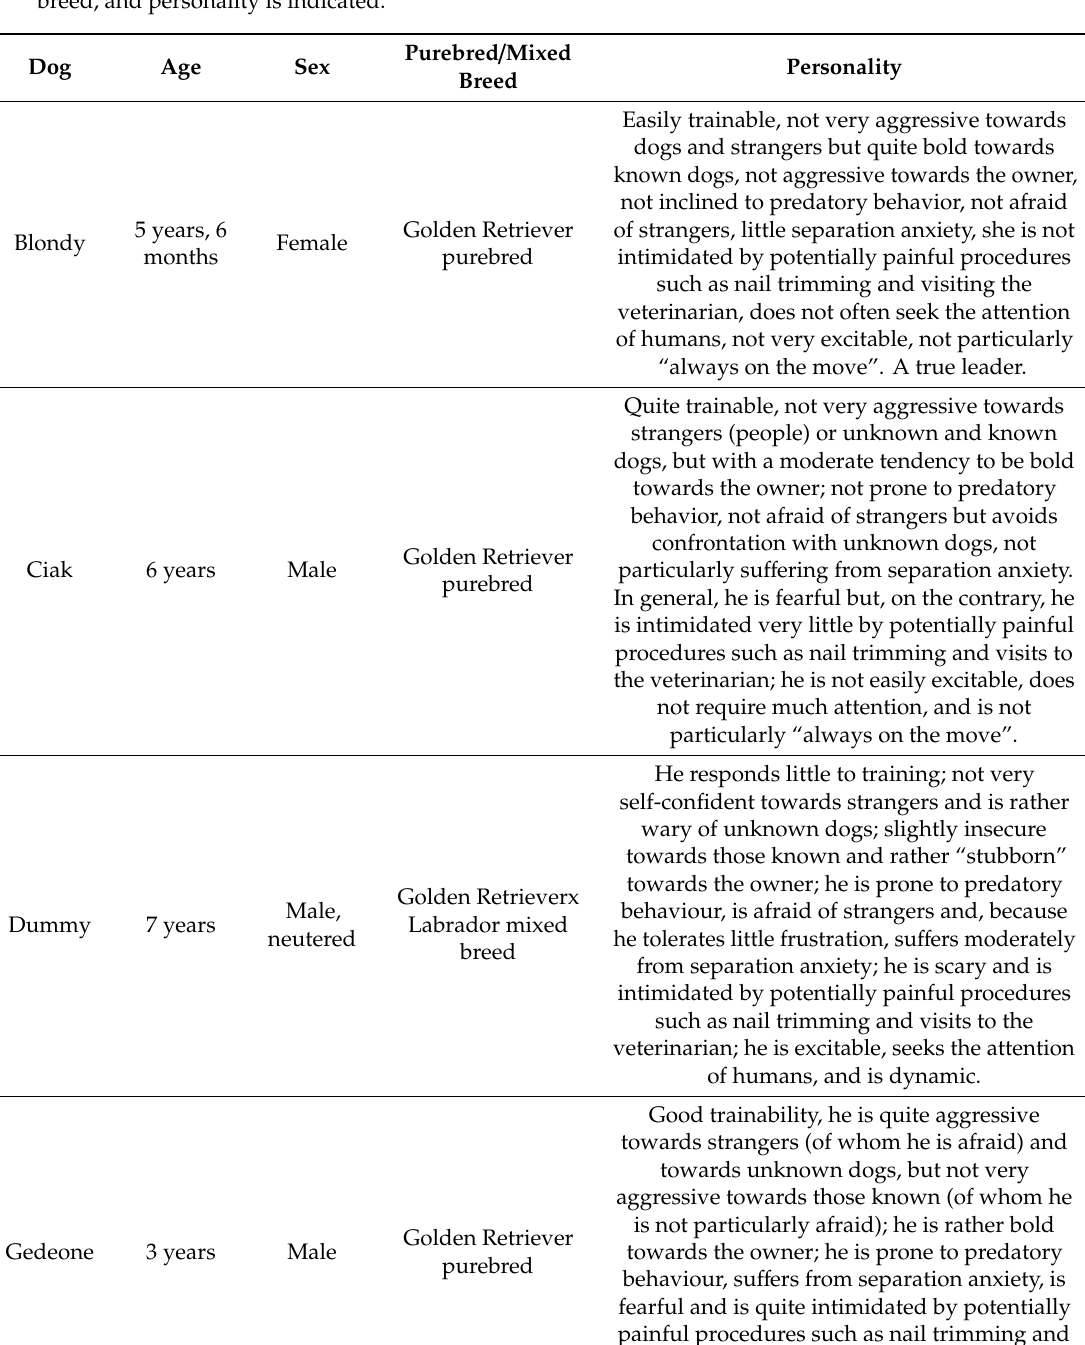
Table 1. The sample of dogs involved in this study. For each individual, the age, sex and sexual status, breed, and personality is